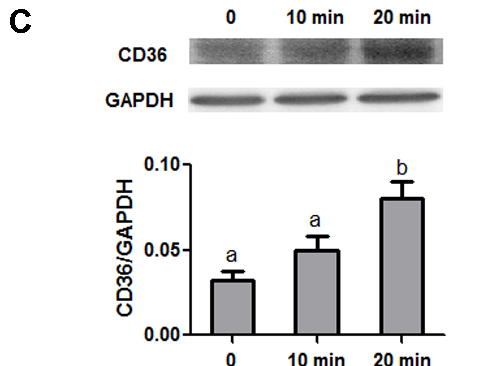
Figure 3. Effect of PA on CD36 expression in N1E-115 cells. Quantitative real-time PCR amplification of CD36 performed with RNA extracted from N1E-115 cells treated with 10 µ mol/L PA at different time points ( A ) or different concentrations of PA for 20 min ( B ), respectively. ( C ) Representative Western blot analysis of CD36 protein in N1E-115 cells induced by 10 µ mol/L PA at 0, 10, and 20 min. Data are expressed as means ± SEM of three different experiments. Groups sharing different letters above the bars indicate statistically significant differences ( p < 0.05), while those denoted by the same letters are insignificant ( A – C ). PA: palmitic acid group.